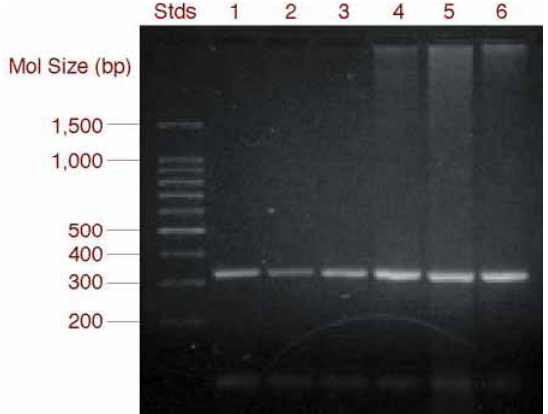
Figure 1. Effect of CAEV infection in vitro on the expression of a 324 bp fragment of MIP-1 α mRNA in goat synovial membrane cells. Total RNA extracted from GSM cells was subjected to RT-PCR using goat specific primers. Samples were electrophoresed on a 2% agarose gel, stained with ethidium bromide and photographed utilizing ultraviolet transillumination. Stds: mol. size marker; Lanes 1-3: Control, uninfected GSM cells; Lanes 4-6: CAEV-infected GSM